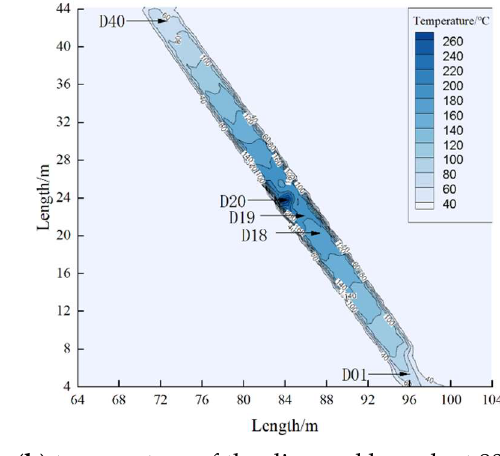
( b ) temperature of the diagonal branch at 80 s. Figure 5. Temperature distribution map in diagonal branch. Figure 5. Temperature distribution map in diagonal